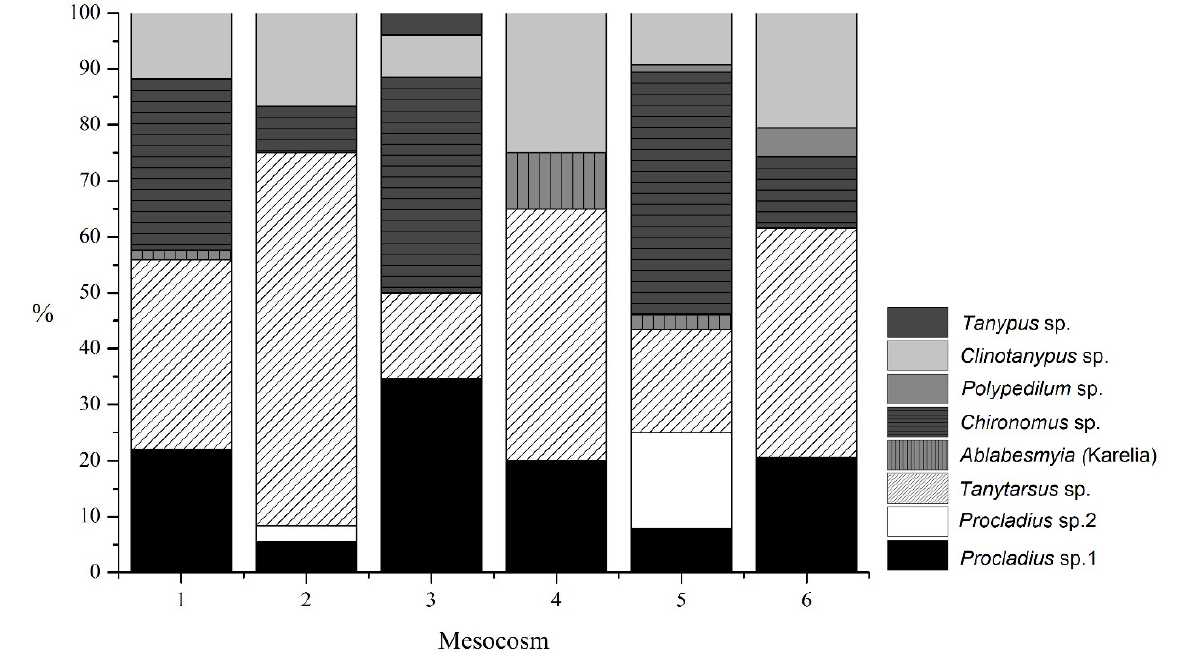
Figure 2. Chironomid species distribution (%) in the six mesocosms. Mesocosms 1, 3 and 4, with Pyrimethanil fungicide and mesocosms 2, 5 and 6, without Pyrimethanil. Table I. Chironomidae abundance in the treated and control mesocosms, during the experiments. Sample dates Oct./12 Nov./12 Jan./13 Feb./13 Mar./13 Apr./13 May/13 Jun./13 Jul./13